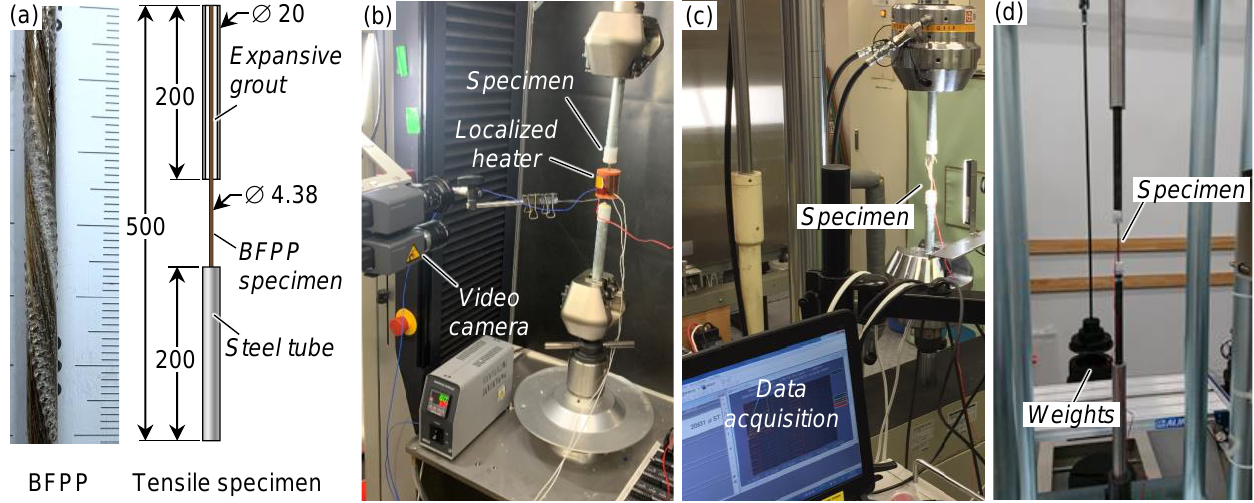
Figure 1. ( a ) Basalt fiber-reinforced polypropylene (BFPP) composite rod (center rod from a seven-wire strand) and tensile specimen diagram (all dimensions in mm), ( b ) static tensile test setup including localized heater, ( c ) fatigue tensile test setup, and ( d ) creep tensile test setup.